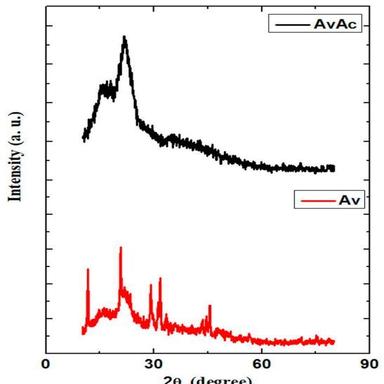
Diffraction of AV powder & AvAc powder.